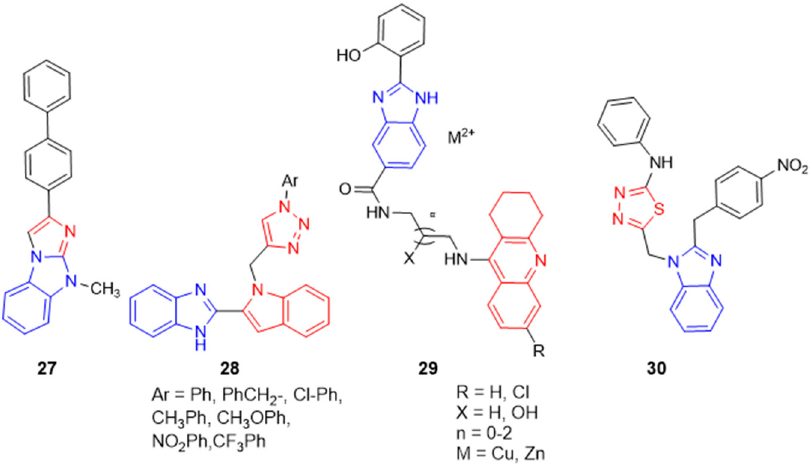
Figure 18. Imidazo–benzimidazole derivative structures.